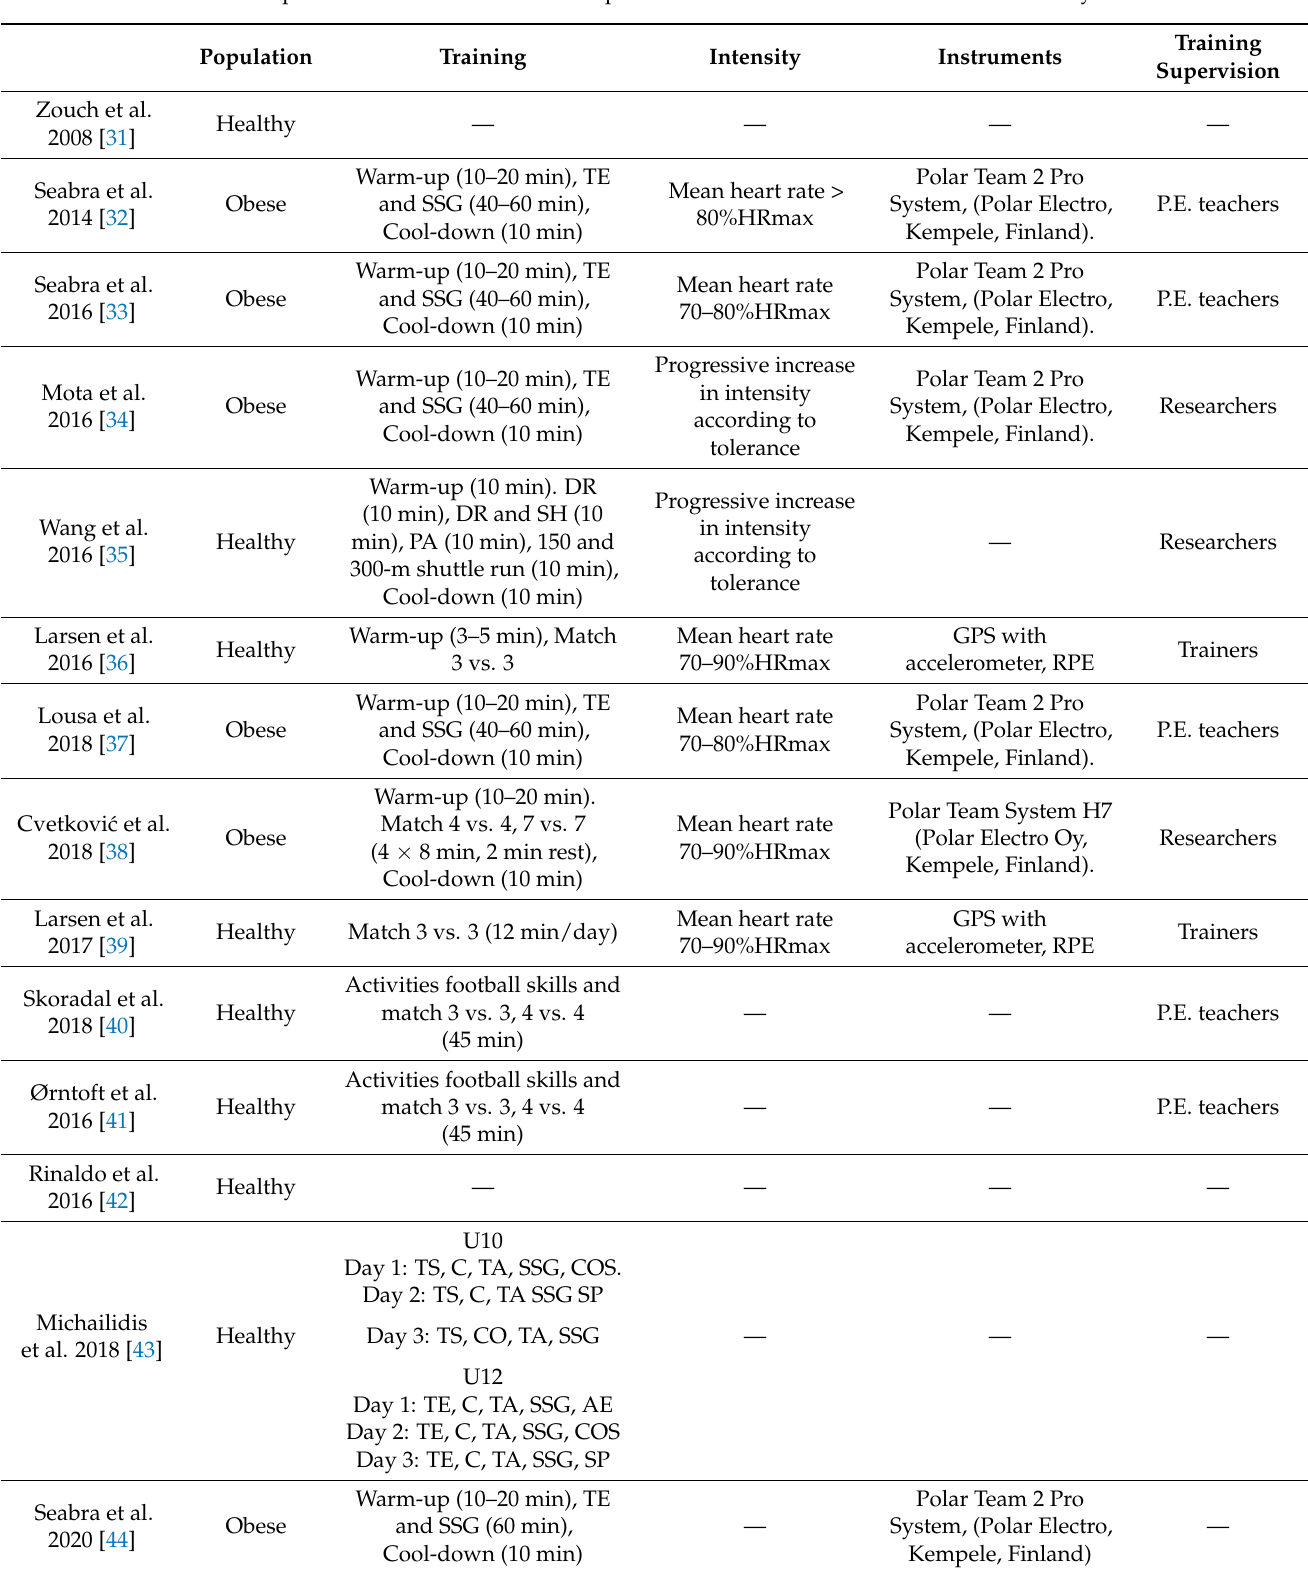
Table 3. Specific characteristics of football practice in the studies included in the meta-analysis. Population Training Intensity